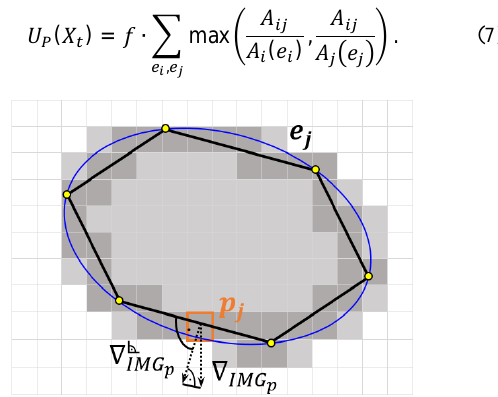
of the ellipse border, here (cid:3037) ⦝ in the direction of the (cid:3010)(cid:3014)(cid:3008) (cid:3291)(cid:3285) . Gray is the gradient in pixel (cid:1868) (cid:3010)(cid:3014)(cid:3008) (cid:3291) (cid:3037)